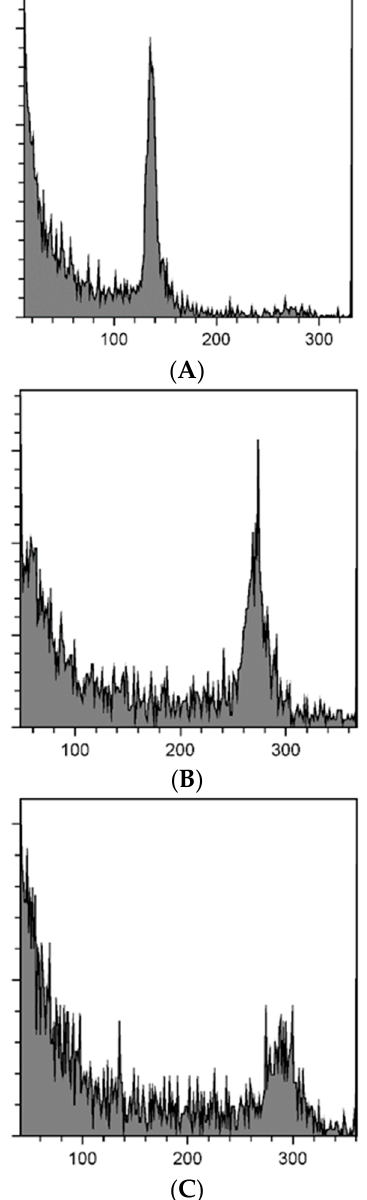
Figure 11. Flow cytometric analyses of Festuca spp.: histograms demonstrate the relative DNA content of ( A ) Festuca vaginata , ( B ) Festuca pseudovaginata and ( C ) Festuca tomanii .